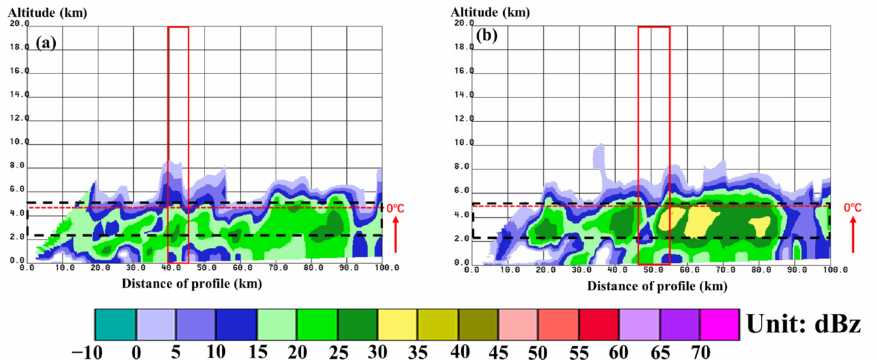
Figure 8. 24 August 2019, ( a ) 12:48 of V4, ( b ) 14:18 of V8. The red rectangle box is the aircraft detection